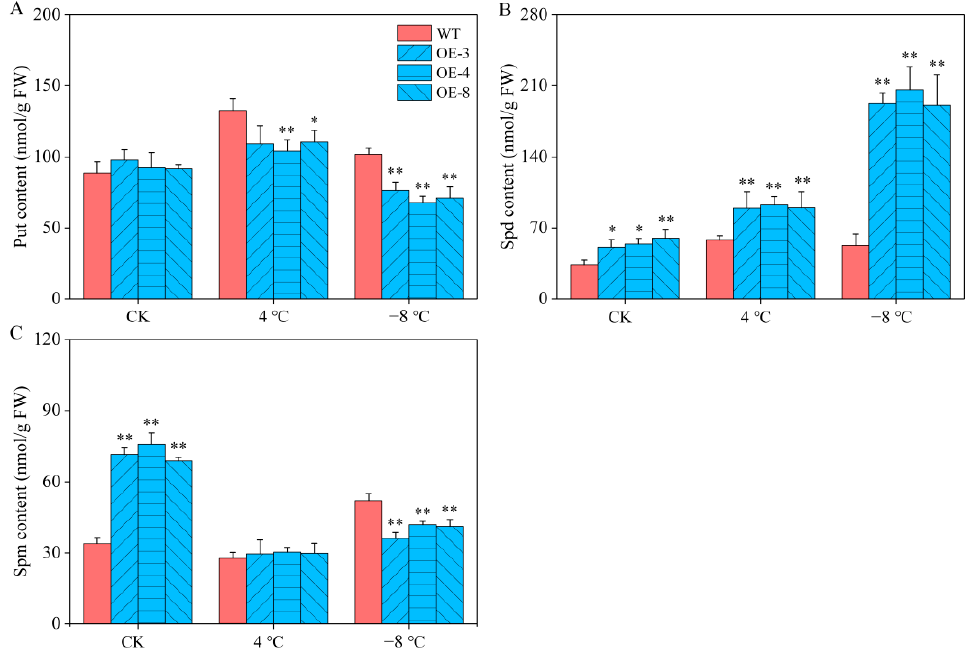
Figure 7. PA content in pepper under cold stress. ( A ) Put content. ( B ) Spd content. ( C ) Spm content. “*” represents p < 0.05, and “**” represents p < 0.01 between WT and transgenic lines.